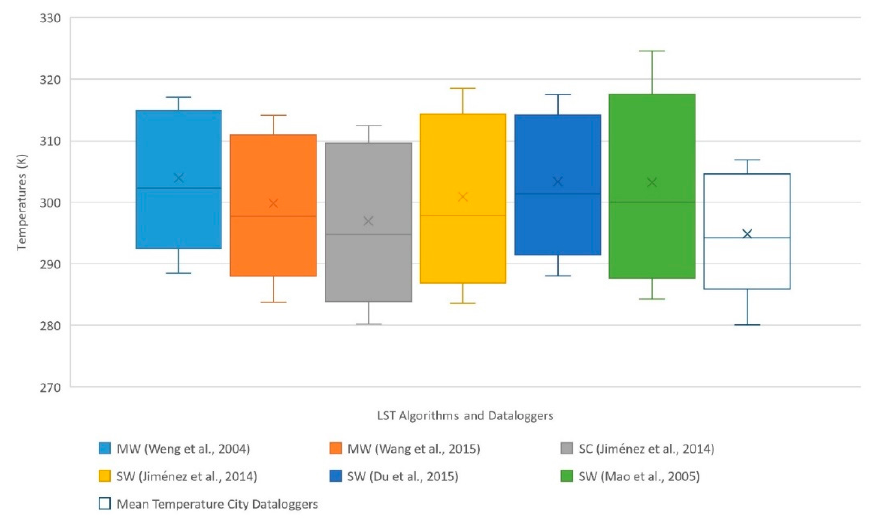
Figure 3. Land surface temperature (LST) maxima, minima and means of each algorithm used.